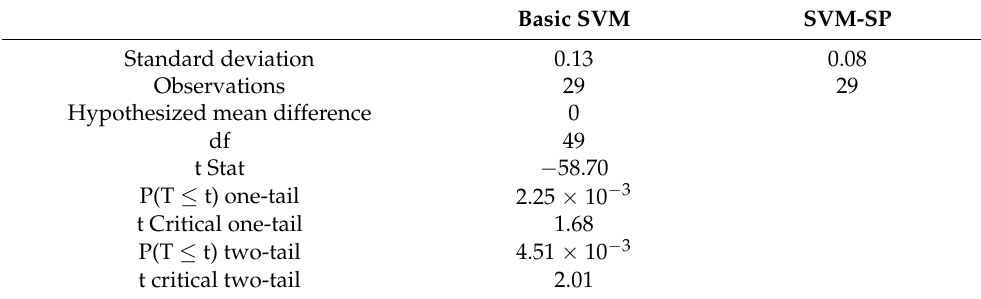
Table A3. t -test: two-sample assuming unequal variances between basic SVM and SVM-SP, simple beam.